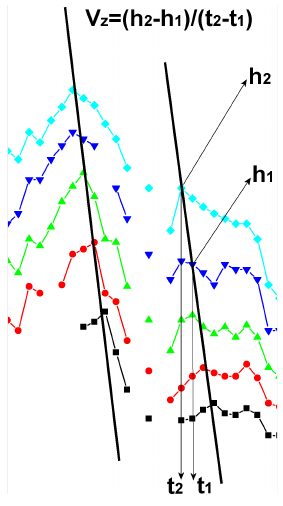
Fig. 4. Enlargement of Fig. 3a from 01:00 to 03:00UT (21:00 to 23:00LT) to show how V z is